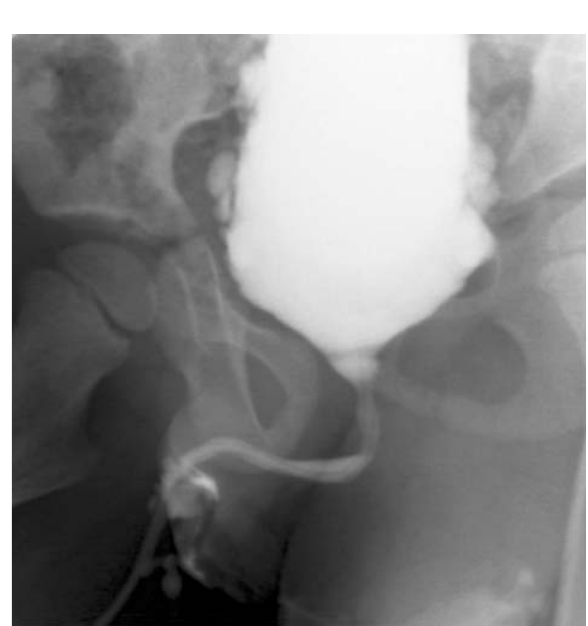
Figure 4 – VCUG: bladder trabeculation and multiple